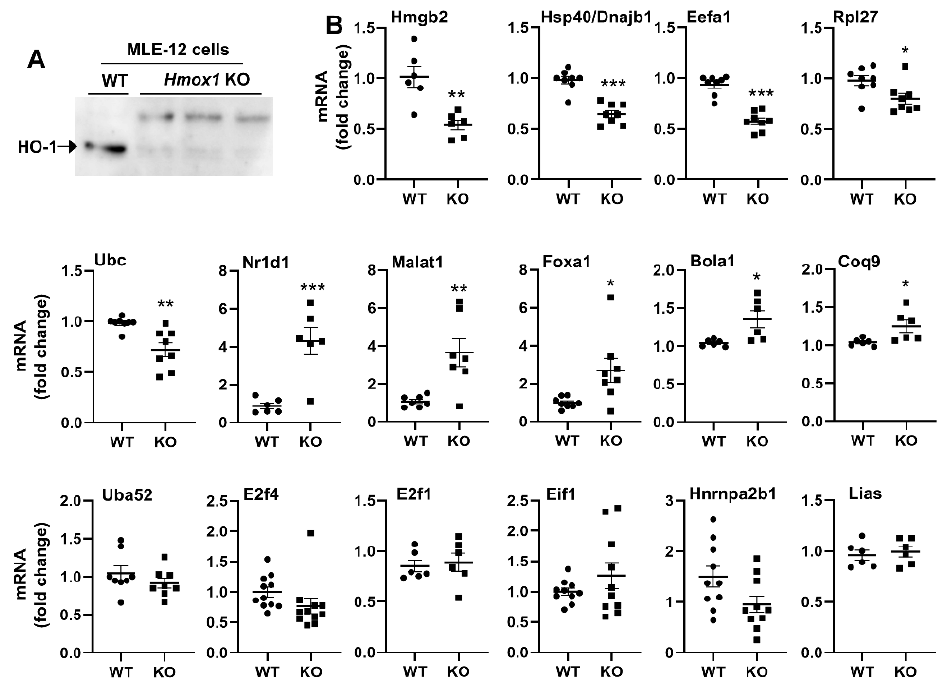
Figure 6. Gene expression in Hmox1 deficient cells. ( A ) Western blot confirmed HO-1 deletion in Hmox1 deficient MLE-12 cells. Each lane was loaded with 10 µ g protein. ( B ) Transcriptional levels of targeted genes measured by qRT-PCR in Hmox1 deficient (KO) and WT MLE-12 cells. Data are expressed as mean ± SEM. N = 6–8. * p < 0.05, ** p < 0.01, *** p < 0.001 vs. WT group.